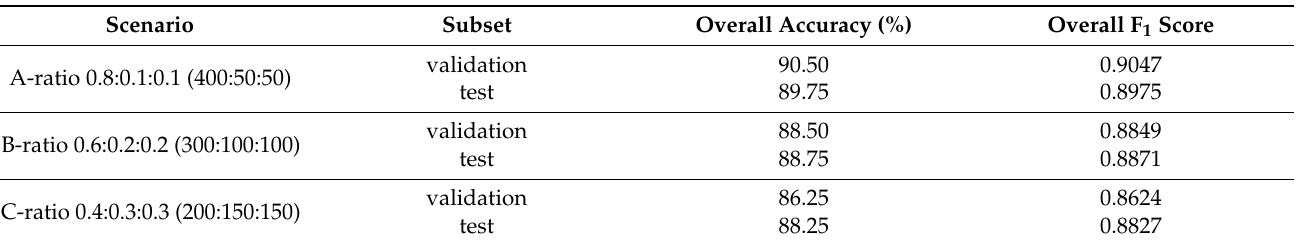
Table 11. Accuracy comparison of the training results of three scenarios of data division by deep learning with the pretrained GoogLeNet